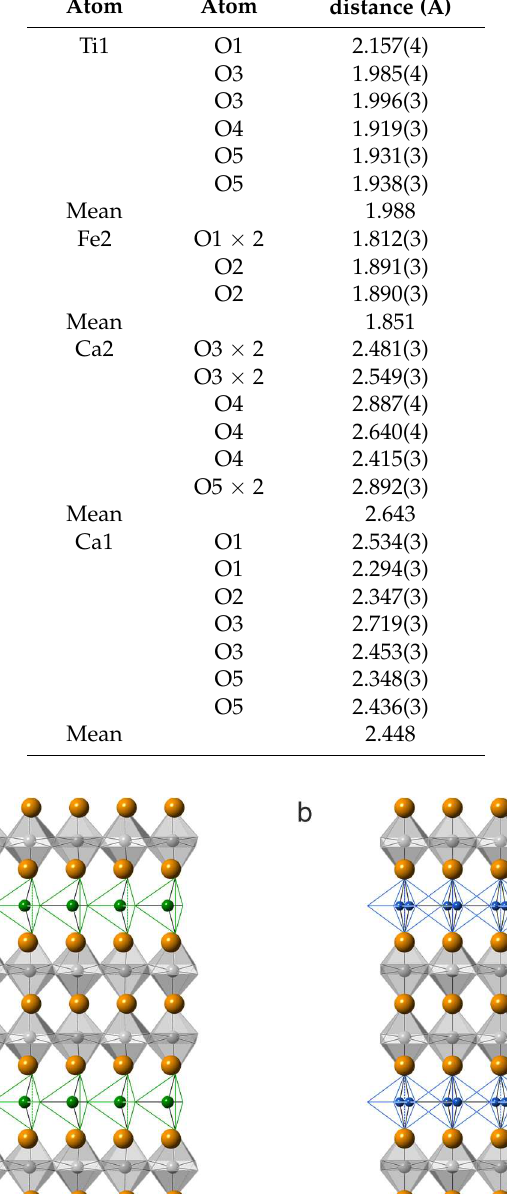
Table 8. Selected interatomic distances (Å) for sharyginite.